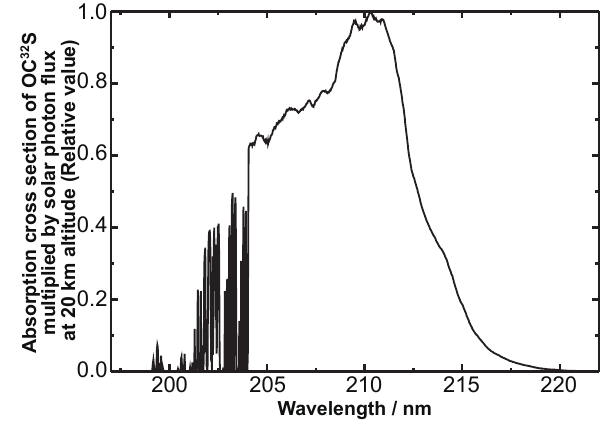
Fig. 6. Photolysis rates as a function of wavelength for OC 32 S at 20km in arbitrary